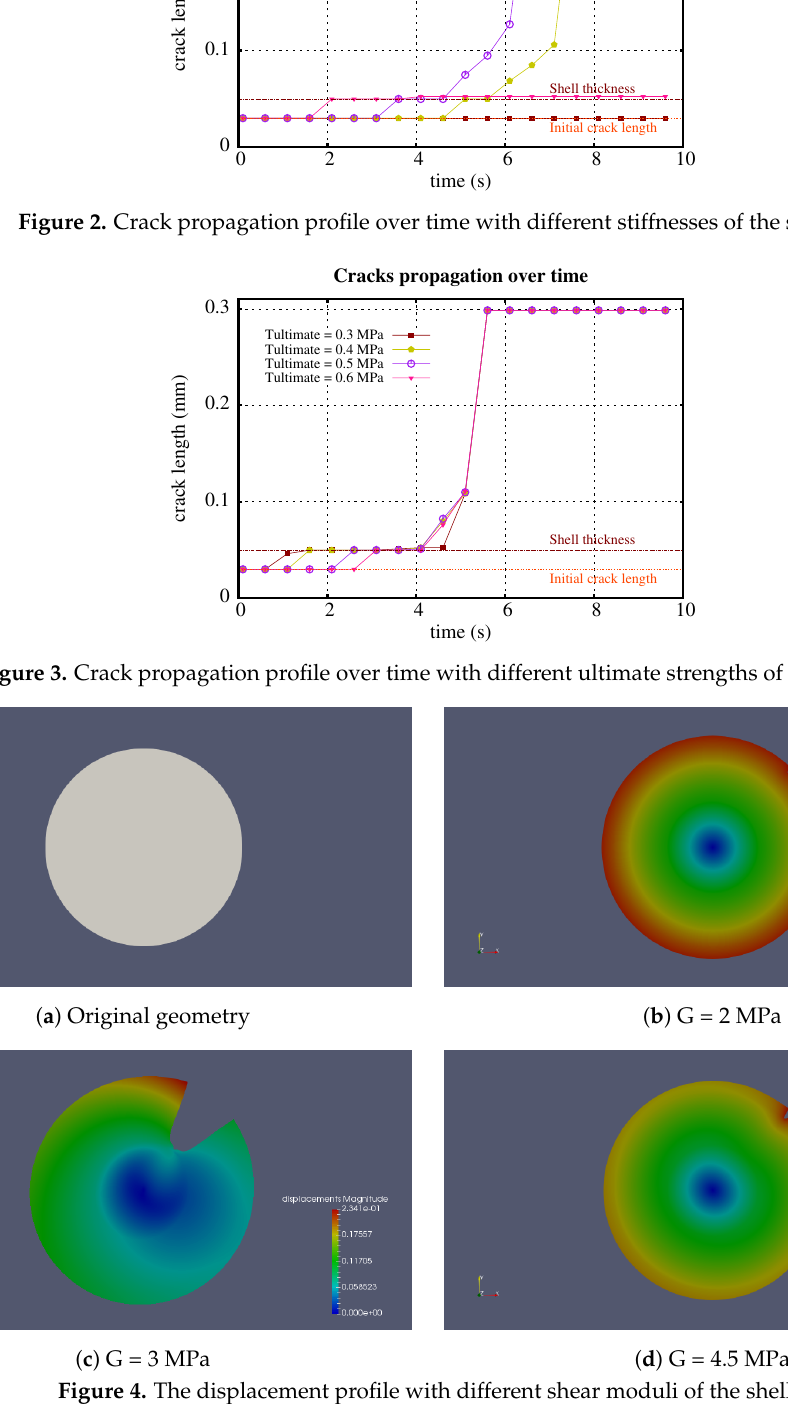
Figure 4. The displacement profile with different shear moduli of the